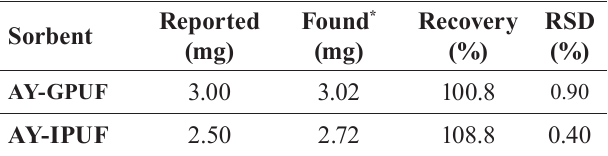
TABLE VI - Determination of CAF in its pharmaceutical dosage (Pronto Plus tablets) applying standard addition technique using imprinted and grafted foam Sorbent